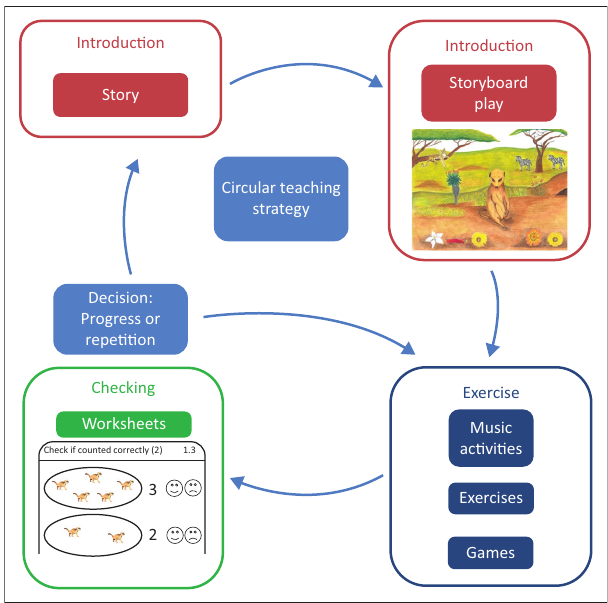
FIGURE 2: Circular teaching strategy following Fritz and Ehlert (2016) and Mueller, Ehlert and Fritz (2017).